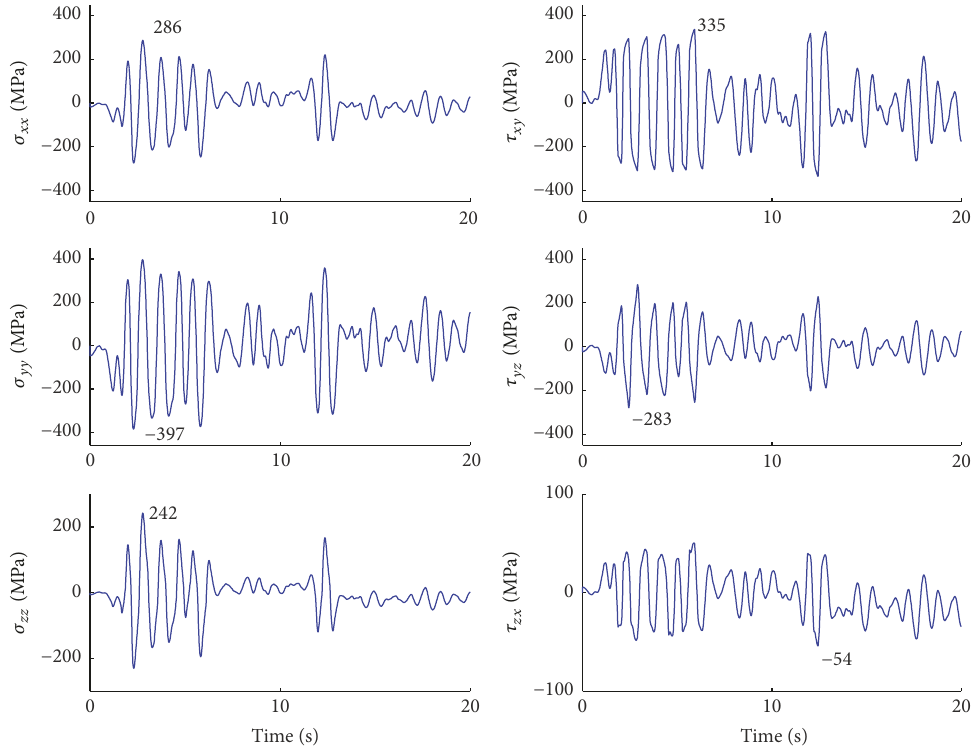
Figure 11: Stress time history of the weld